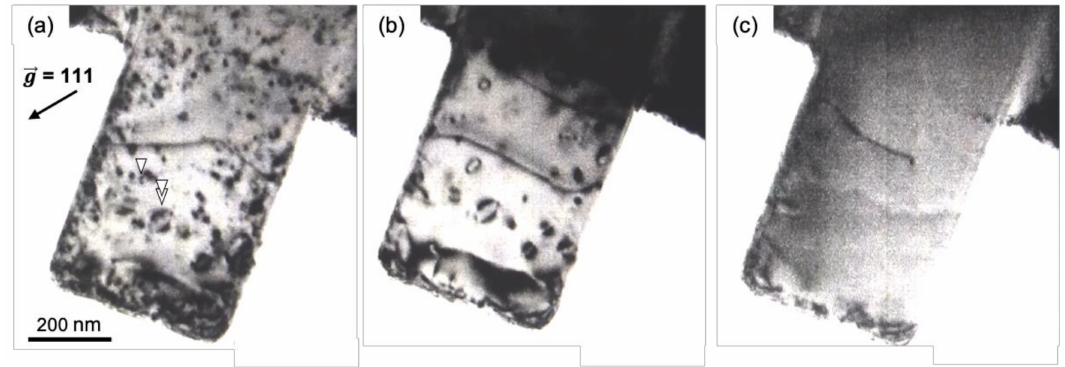
Figure 2. Series of snapshots showing the microstructural changes during the annihilation of the defects induced by FIB in Al in the TEM in situ heating experiment. ( a ) 303K, ( b ) 458 K, and ( c ) 573